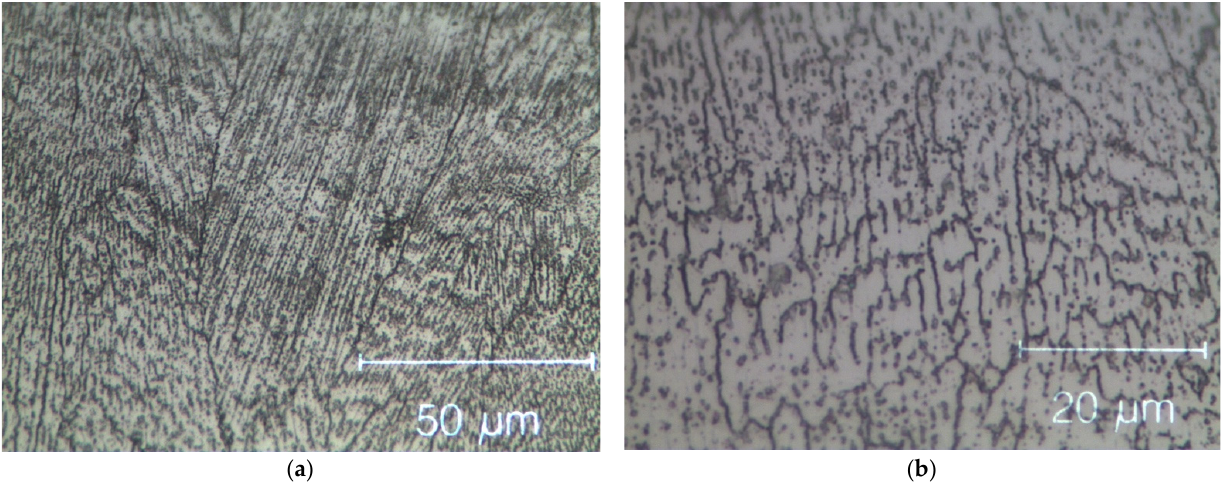
Figure 4. Optical micrographs of the as-built SLM HEA observed in transversal section. ( a ) Columnar grains aligned towards the build direction. ( b ) Dendritic structures inside the grains.